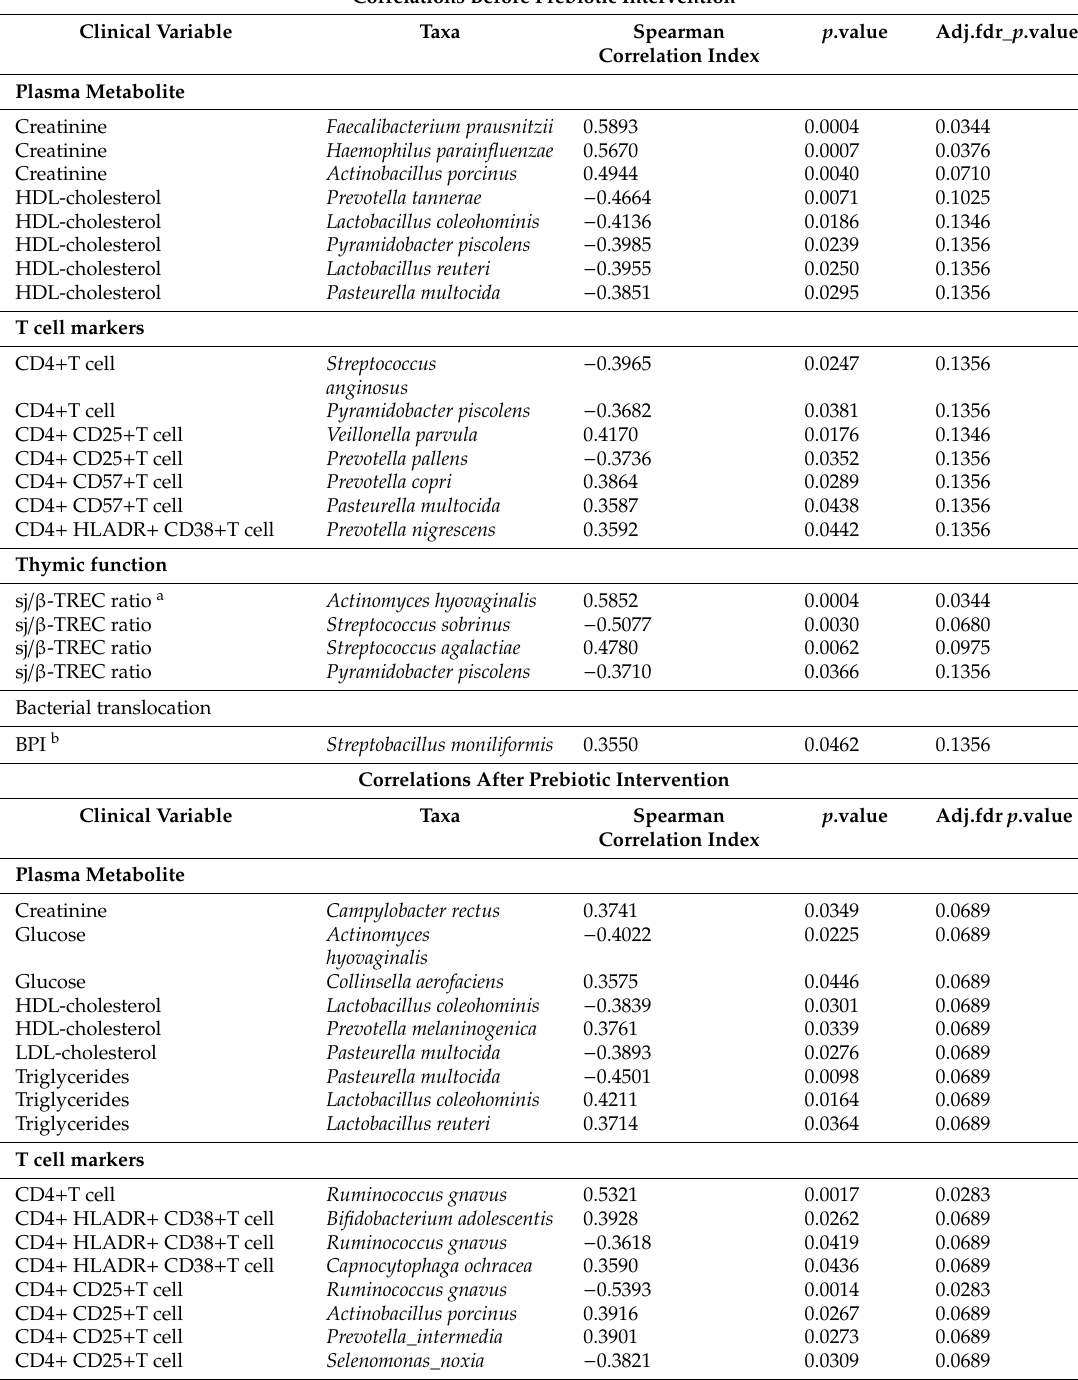
Table 3. Correlations between saliva microbiota and clinical parameters at baseline and after treatment. Analysis was performed using Kruskal–Wallis test to compare median values across all groups. The p -value is the probability at α =